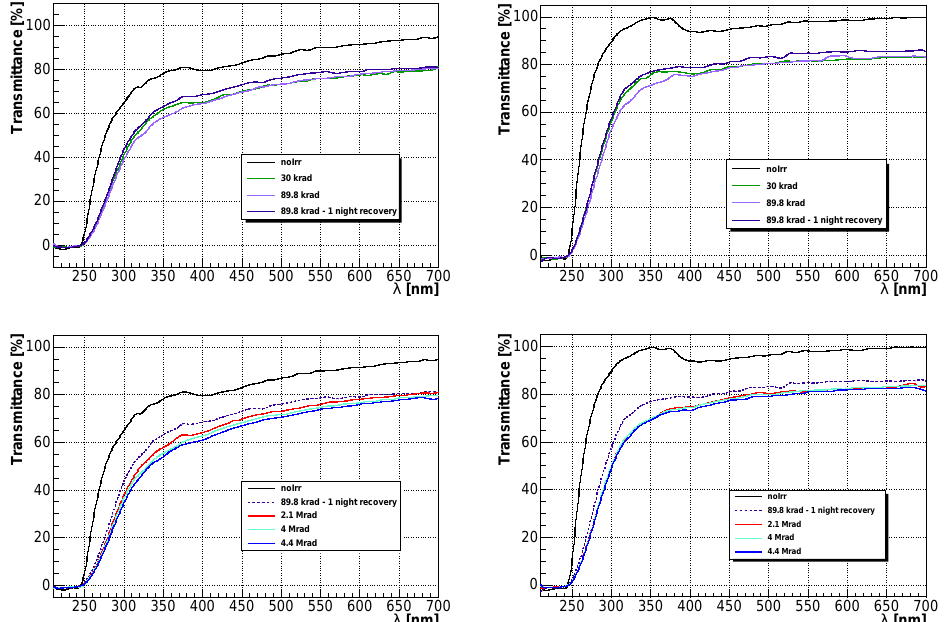
Figure 5. Transmission spectra obtained in the different irradiation steps for the naked crystal ( top and bottom left ) and the crystal with Mylar wrapping ( top and bottom right